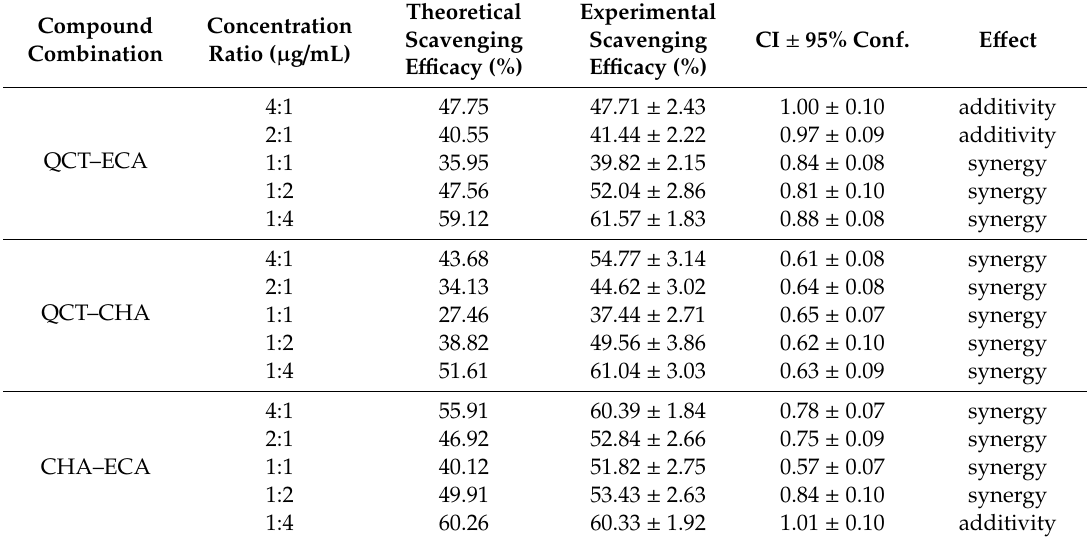
Table 4. The synergistic e ff ects between the main extracts’